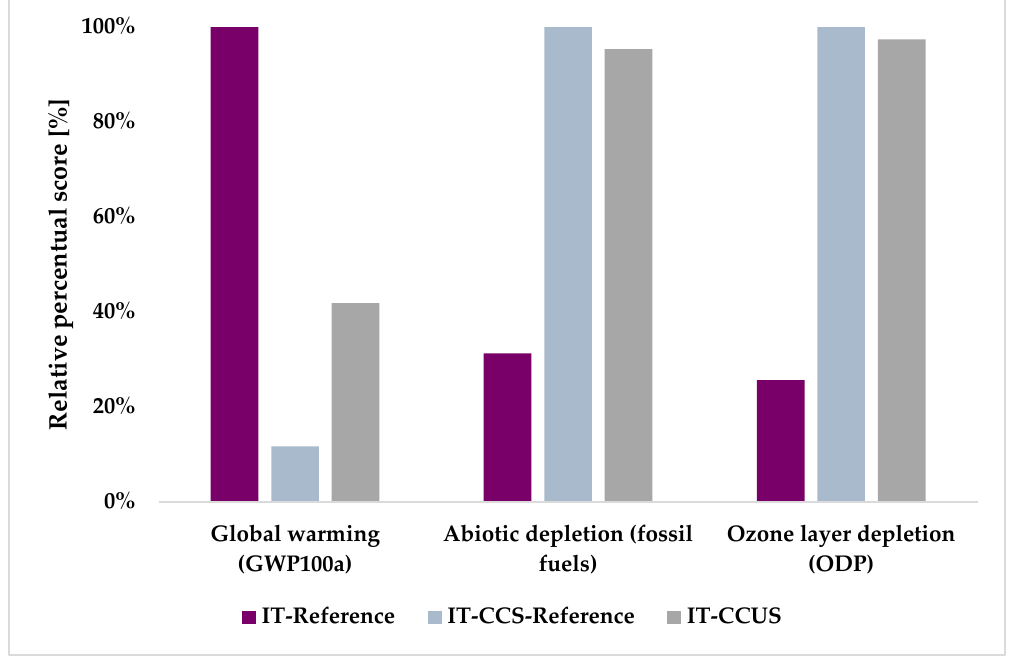
Figure 7. Impact category scores for the Italian case study in the CCUS scenario considering a comparable CCS reference scenario.